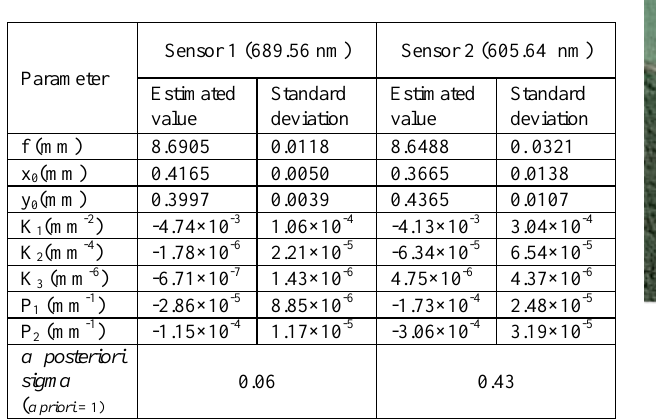
Table 2. IOPs determined by self-calibration.